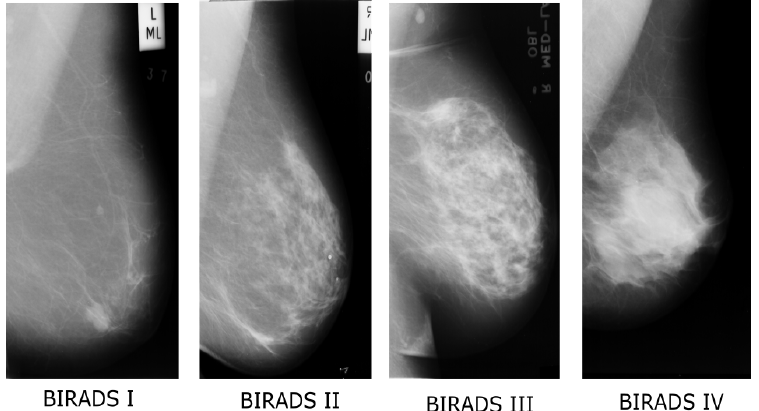
Figure 1. Examples of breast density according to Breast Imaging-Reporting and Data System classes